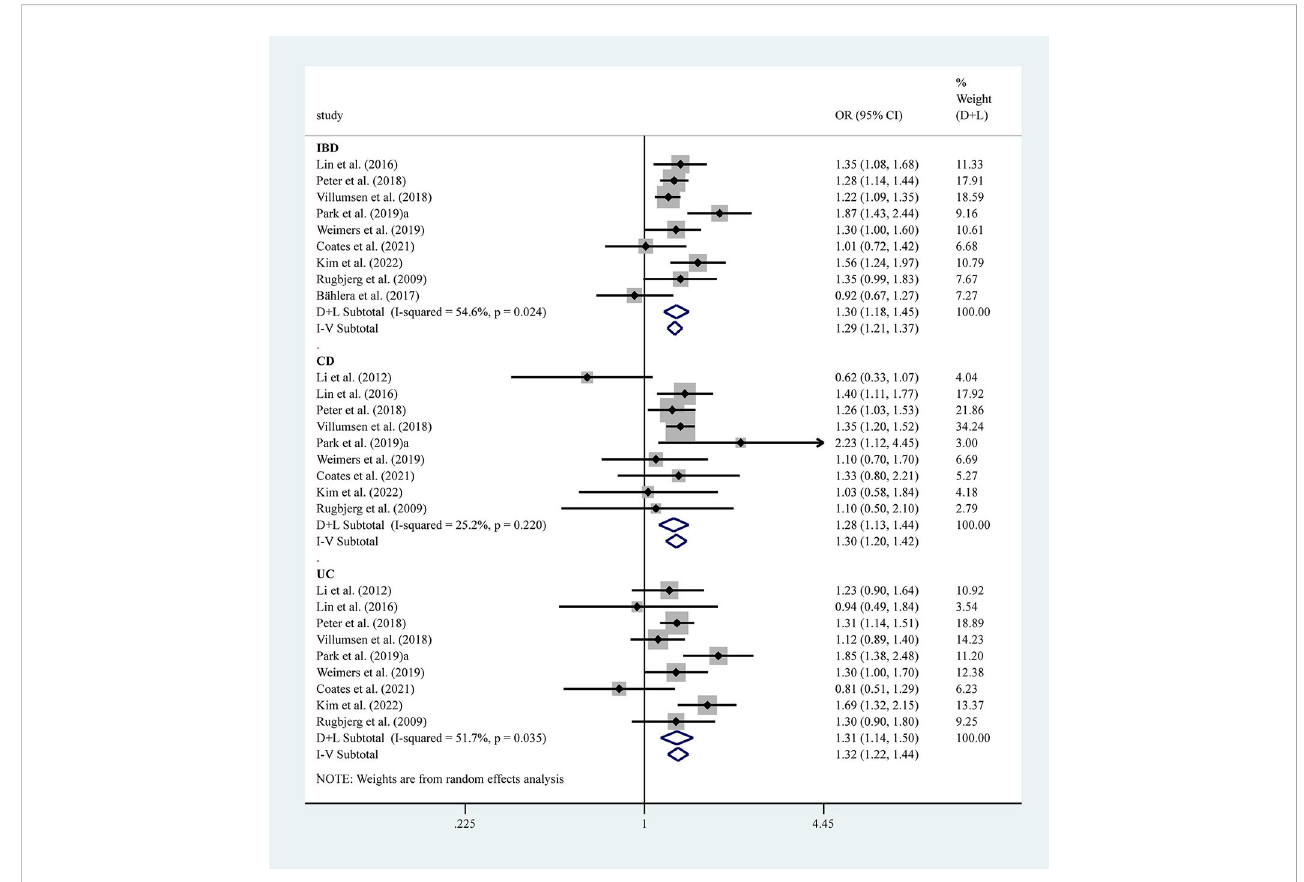
FIGURE 4 Forest plots of studies association between PD and IBD (including UC and